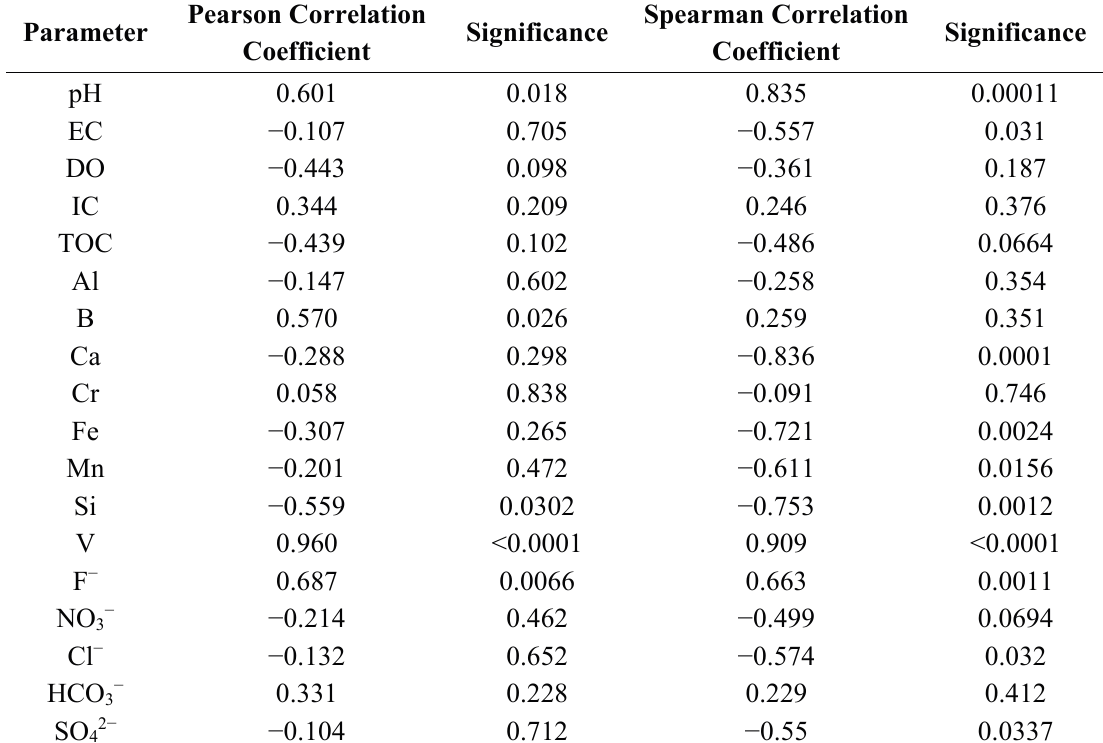
Table 1. Pearson (2-tailed) and spearman correlation coefficients for total arsenic and analysed water quality